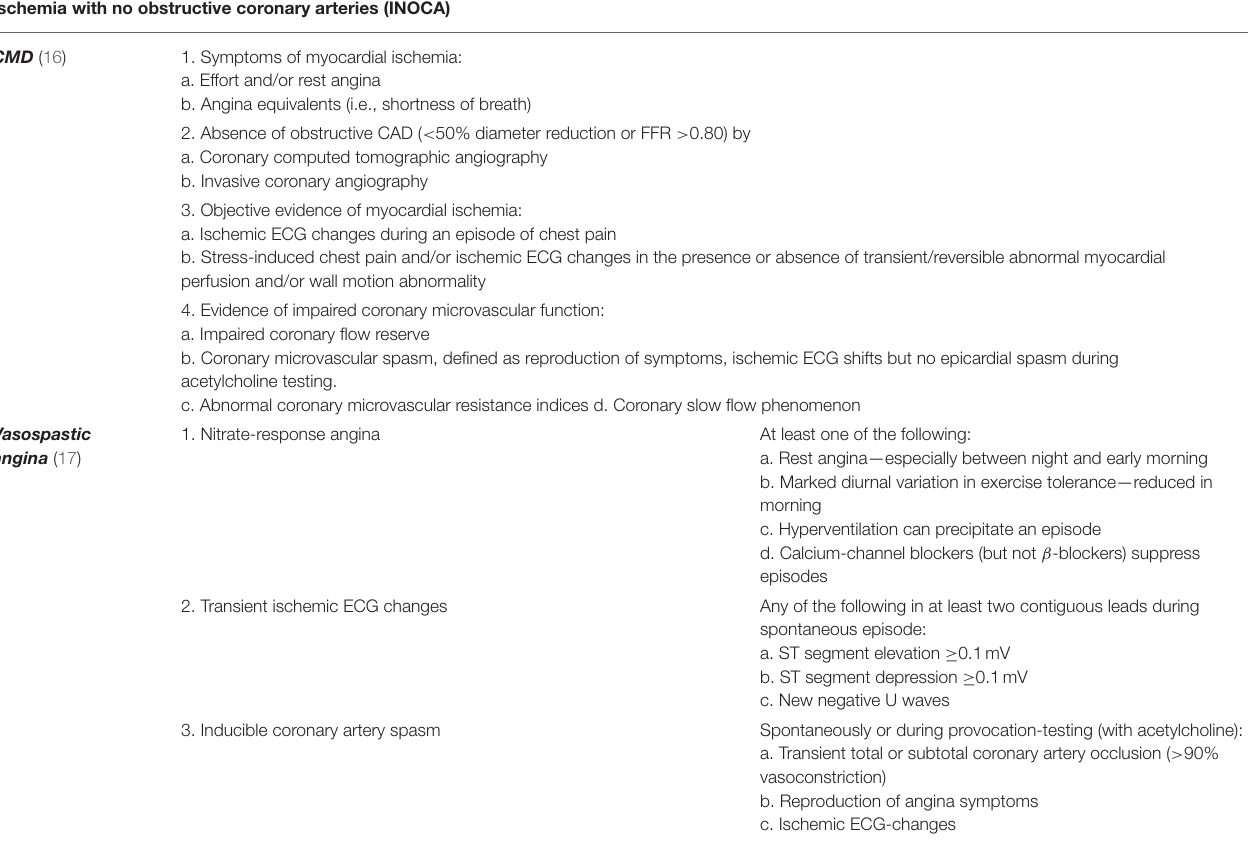
TABLE 1 | Entities of INOCA according to the COVADIS-criteria. Ischemia with no obstructive coronary arteries (INOCA) CMD (16)